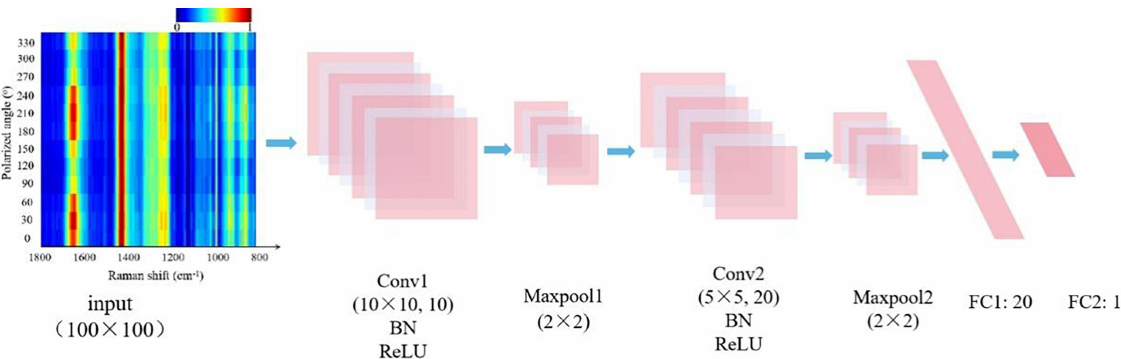
Figure 1. The architecture of the 2D-CNN discriminant model. Two convolutional layers were abbreviated as Conv1 and Conv2, as well as two fully connected layers as FC1 and FC2. The max-pooling layers are Maxpool1 and Maxpool2,